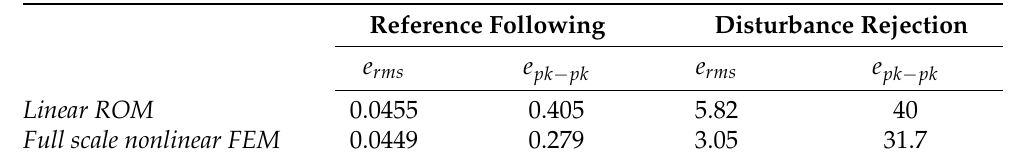
Table 3. Comparison of average and worst-case prediction error of linear and nonlinear model in the closed-loop reference-following and disturbance rejection experiments Reference